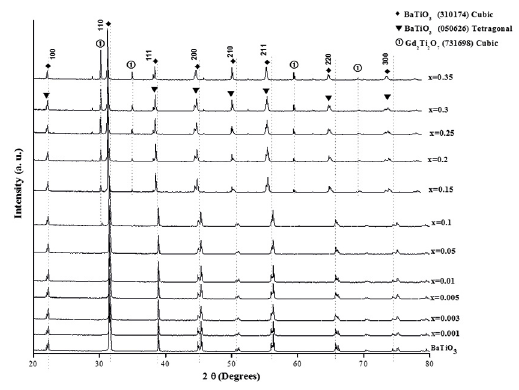
Gd Ti O powders sintered 1-x x 1-x/4 3